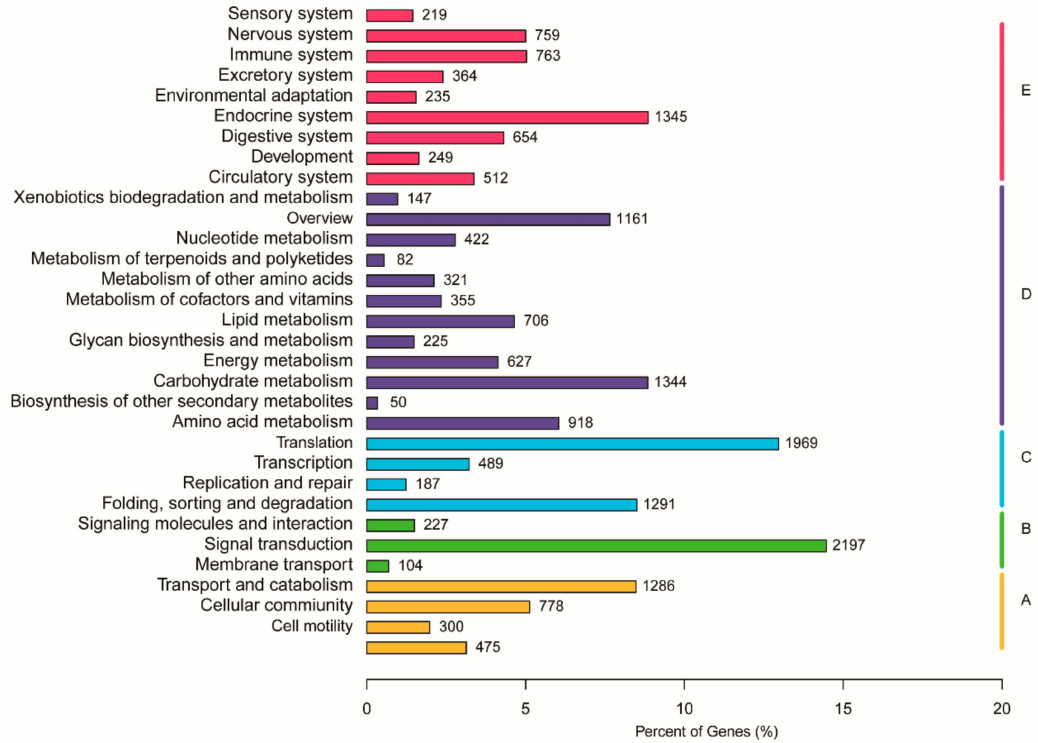
Figure 5. Functional annotation and classification of unigenes from Vespa velutina transcriptome in Kyoto Encyclopedia of Genes and Genomes (KEGG). Five categories were observed: A, cellular processes; B, environmental information processing; C, genetic information processing; D, metabolism; and E, organismal